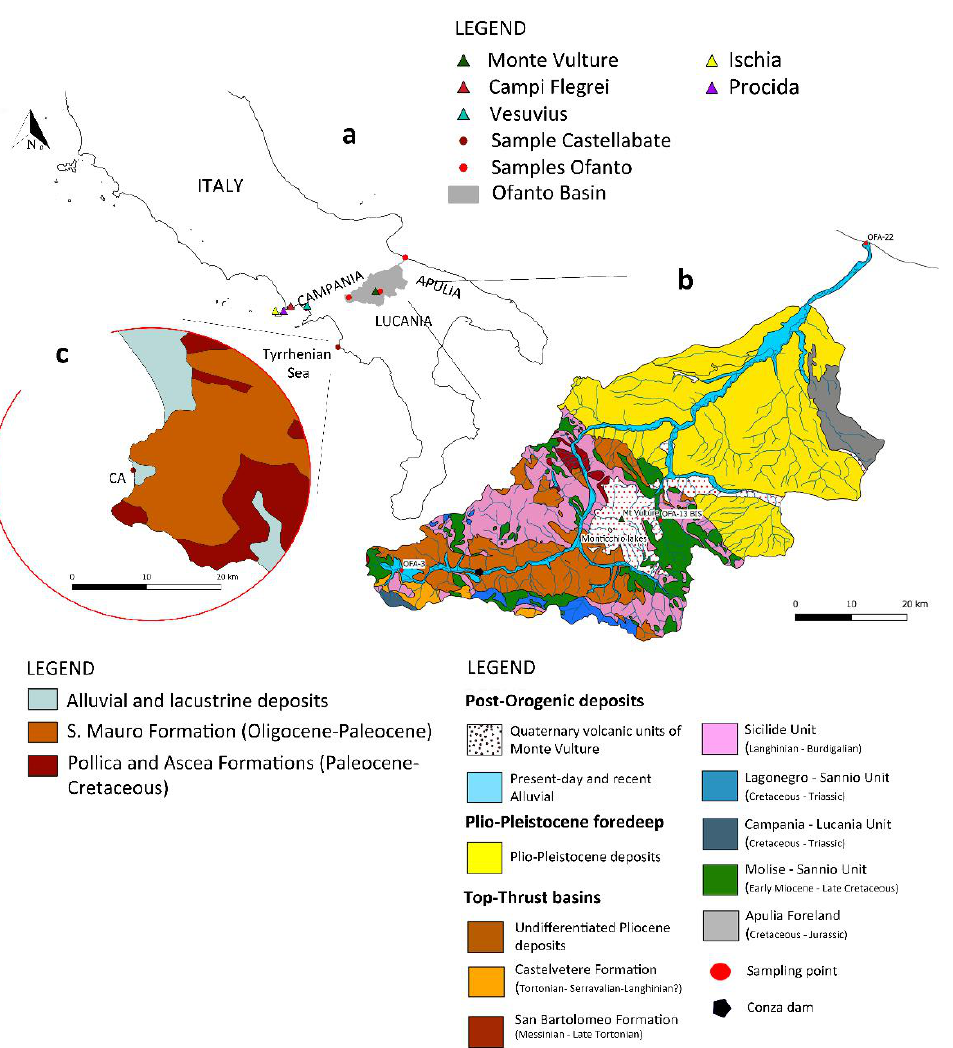
Figure 1. ( a ) Location of the Ofanto Basin and sampling points. The position of the main volcanoes of the area is also shown; ( b ) Geological map of the Ofanto Basin (modified after [10]). The position of the sampling points and the Conza dam is also shown; ( c ) Geological map of the area of Castellabate (modified after [12]).